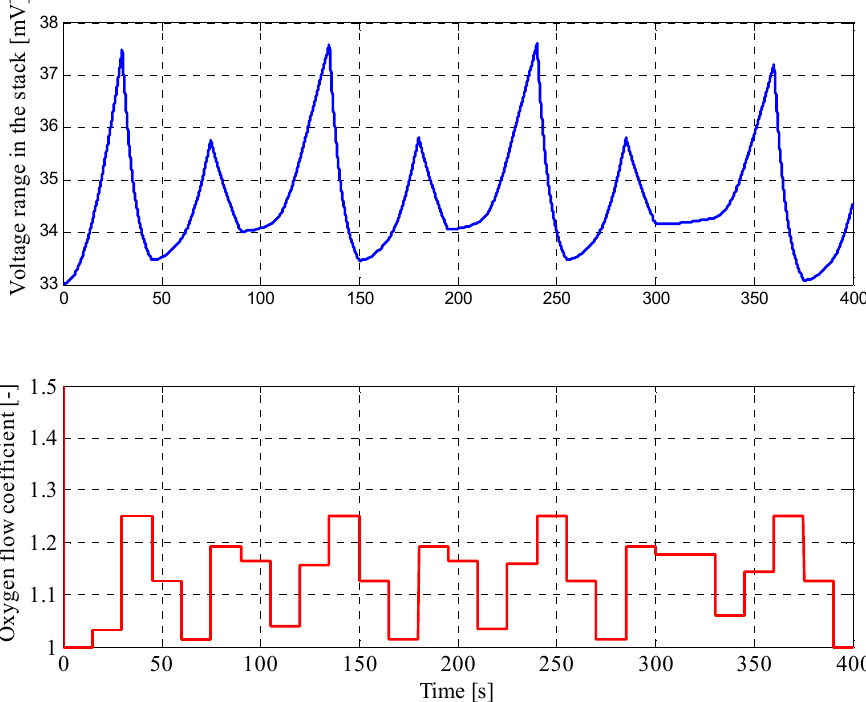
Figure 14. Voltage range and oxygen flow coefficient for the fuzzy control procedure with simulation parameters set to (cid:1844) (cid:3022),(cid:3053) = 35 mV and ∆(cid:1872) (cid:3046) = 15 s (initial (cid:1844) (cid:3022) = 33 (mV), (cid:1863) (cid:3016)